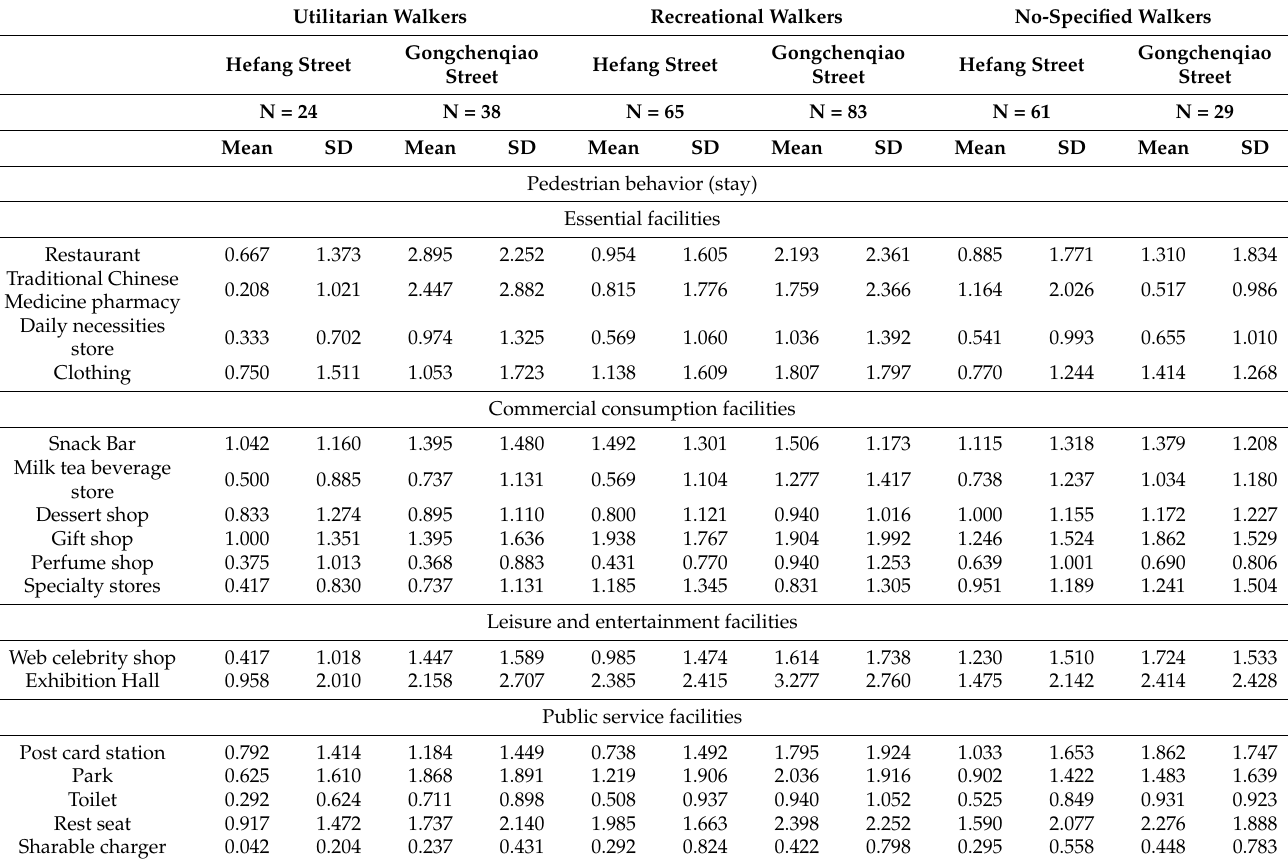
Table 5. Mean and standard deviation of dwell time in street furniture for different pedestrian